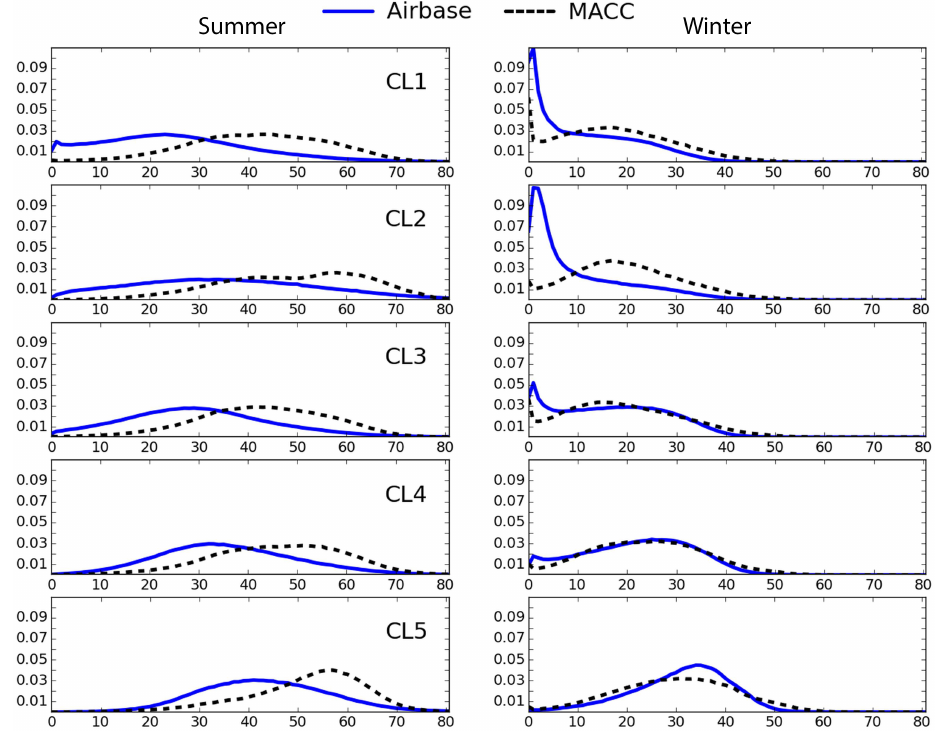
Figure 9. Normalized frequency distributions of 3-hourly ozone values in clusters (2007–2010), in summer (left) and winter (right); Airbase vs. MACC, first CA.